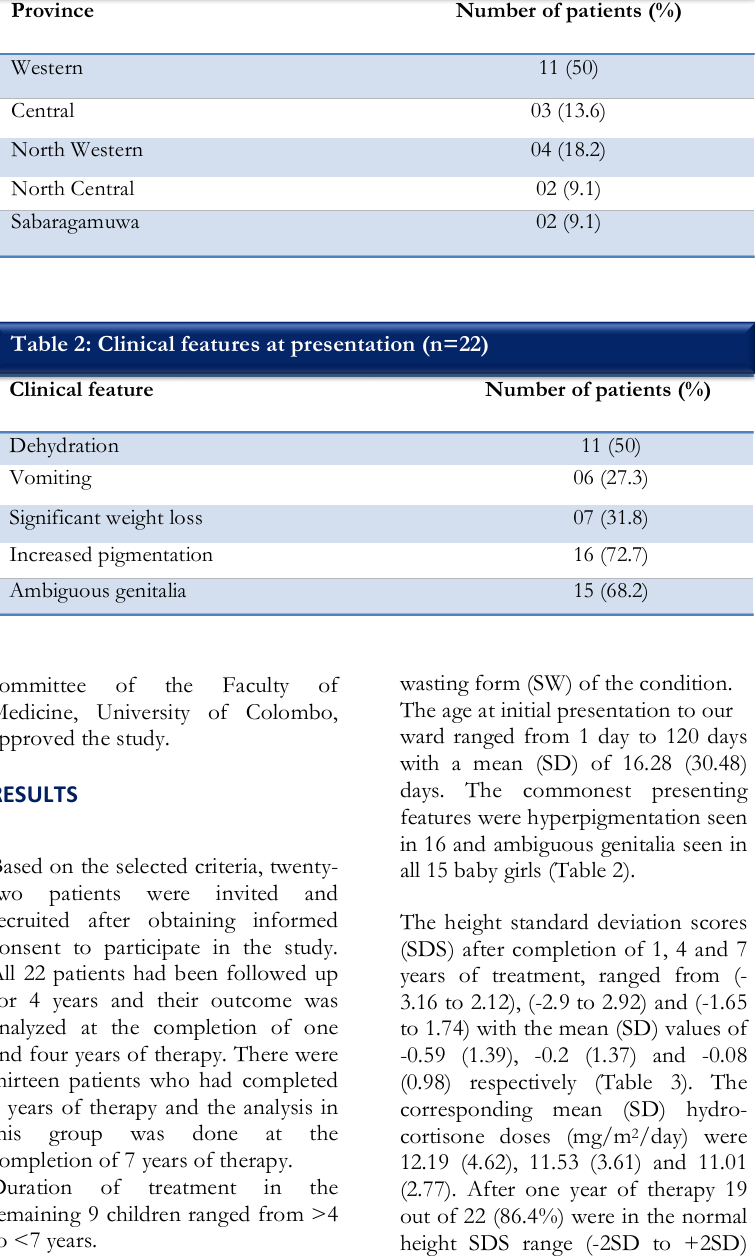
Table 1: Province of residence of the patients ( n=22)